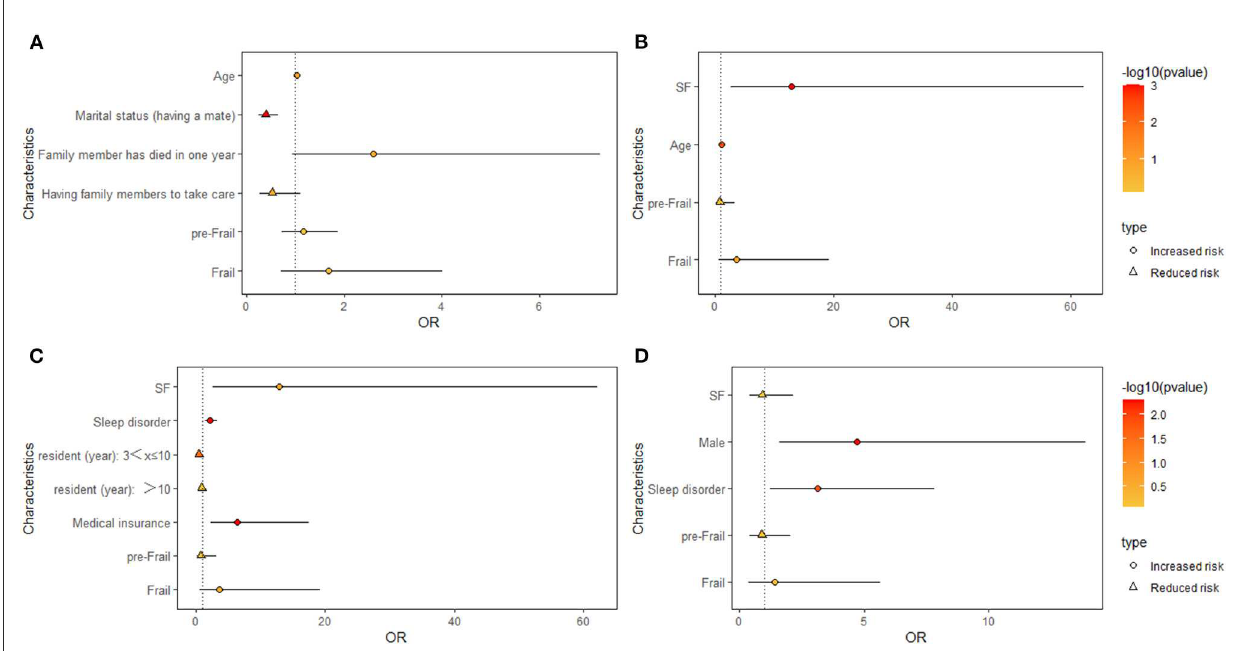
FIGURE2 Forest plots showing the analysis of risk factors associated with SF (A) and cross-sectional analyses of baseline SF with adverse health events in wave 1 (B–D) . (B) Cross-sectional analyses of baseline SF with disability. (C) Cross-sectional analyses of baseline SF with hospitalization. (D) Cross-sectional analyses of baseline SF with